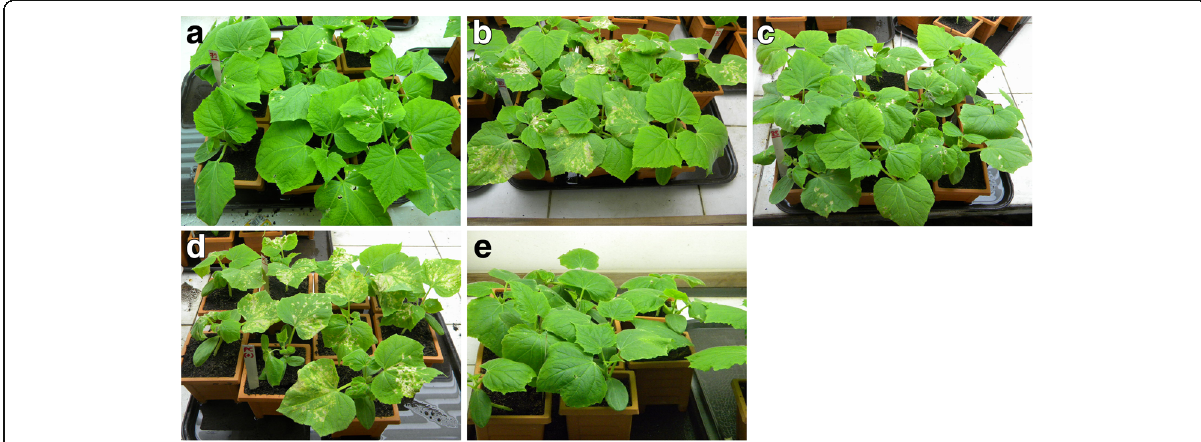
Fig. 1 a The symptom development of Pseudomonas syringae pv. lachrymans on cucumber plants treated with isolate (CA332-73) 7 days after pathogen inoculation. b The symptom development of Pseudomonas syringae pv. lachrymans on cucumber plants treated with isolate (CC361-80) 7 days after pathogen inoculation. c The symptom development of Pseudomonas syringae pv. lachrymans on cucumber plants treated with isolate (CC372-83) 7 days after pathogen inoculation. d The symptom development of Pseudomonas syringae pv. lachrymans on cucumber plants inoculated with pathogen only 7 days after pathogen inoculation (positive control). e The cucumber plants treated with only sterile distilled water (negative